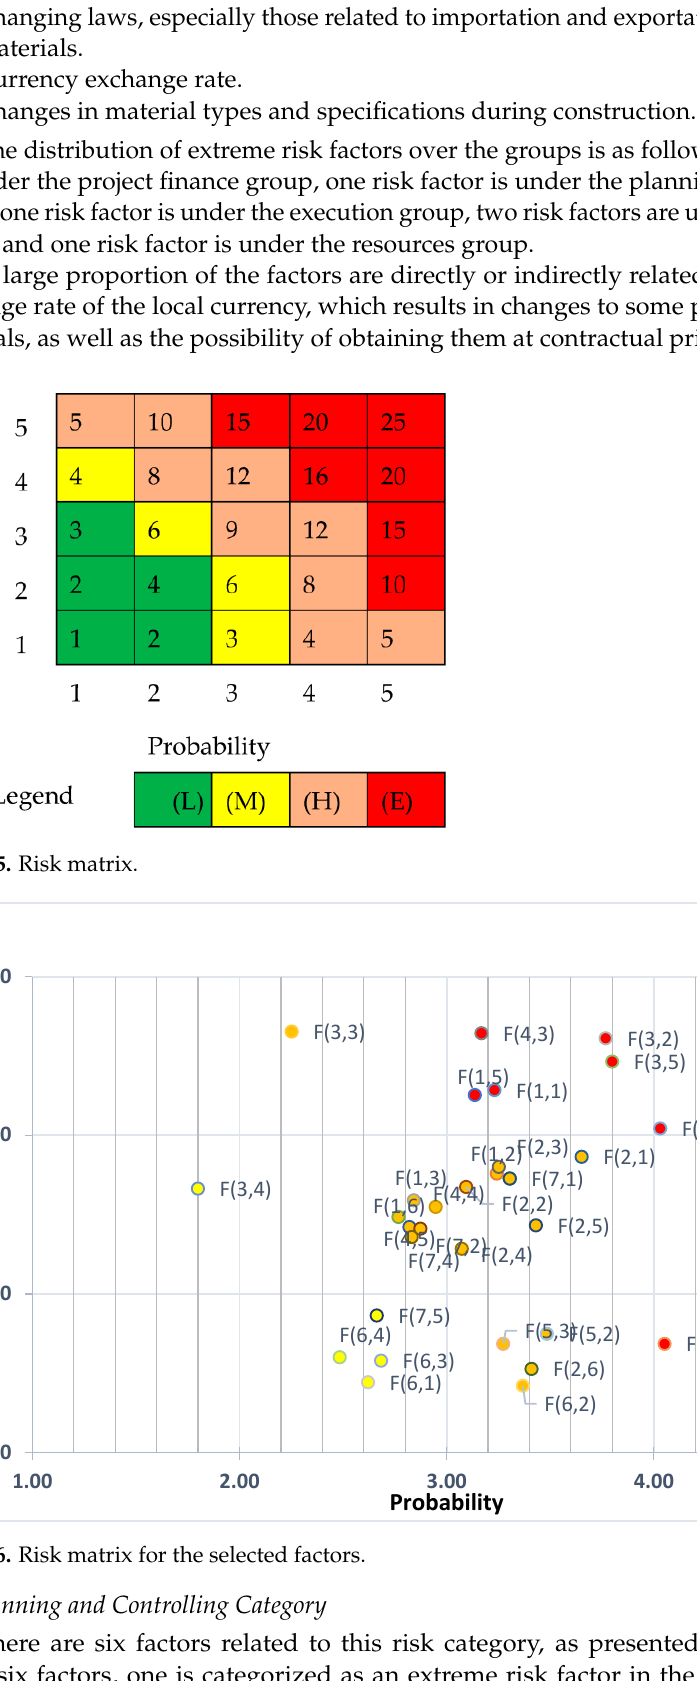
Figure 6. Risk matrix for the selected factors.